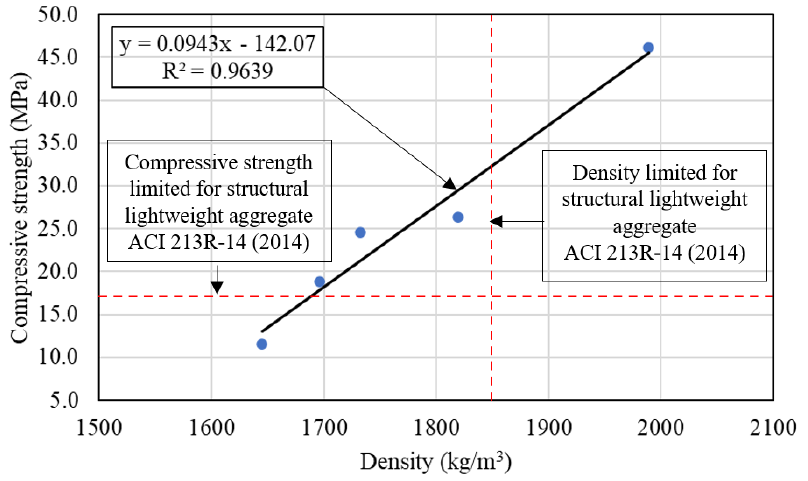
Figure 11. Relationship between density and compressive strength of geopolymer mortar containing BLWA compared with the limited for structural lightweight aggregate as ACI 213R-14 [58].